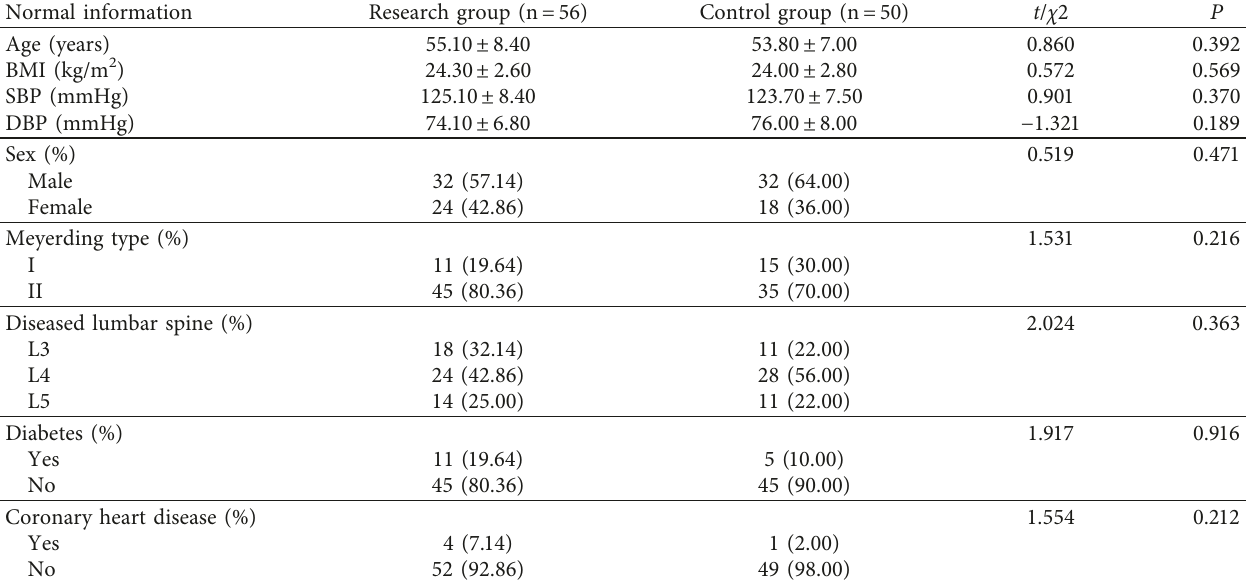
Table 1: Comparison of general data of the two groups of patients. Normal